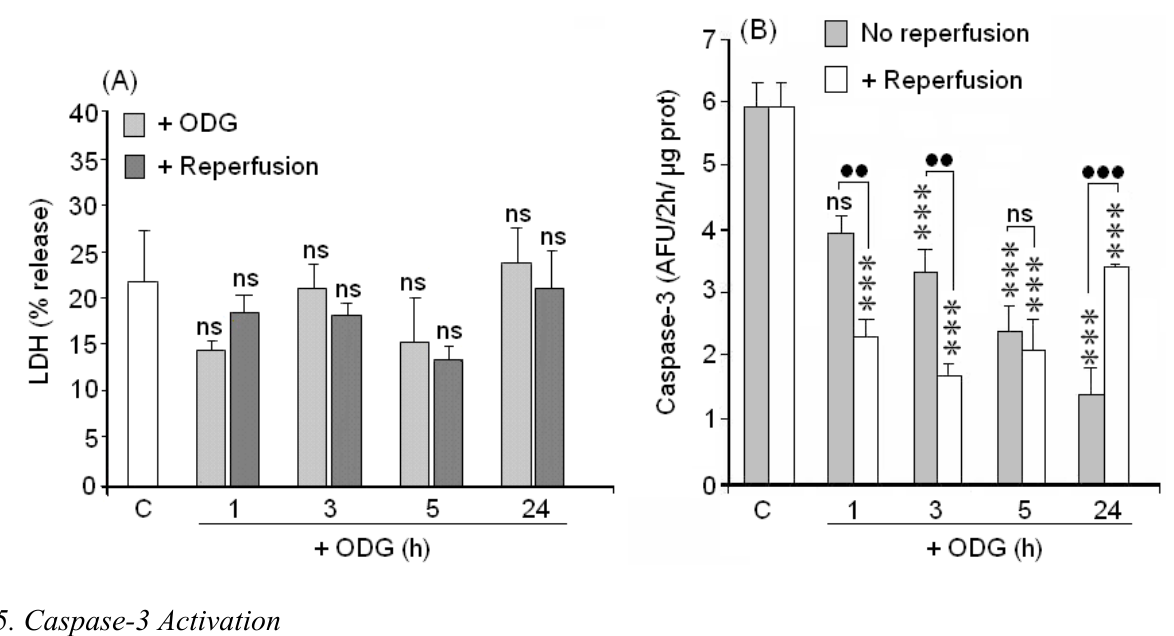
Figure 4. Evaluation of cellular death. ( A ) Necrosis was evaluated by LDH release; ( B ) Apoptosis was evaluated by caspase-3 activity. Results are means ± SEM of three experiments with cells from different cultures, each one was performed in triplicate with different batches of cells (9 measurements/condition). ns = no significant ( vs .